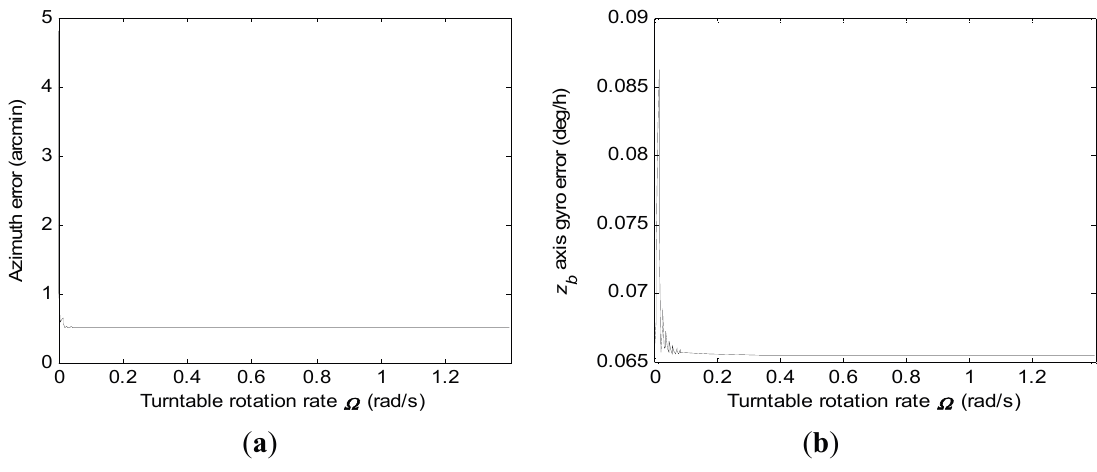
Figure 4. 1- σ values of final azimuth error and final z b axis gyro error at 600 s computed according to turntable rotation rates ranging from 0.0003 rad/s to 1.4 rad/s when using the conventional KF scheme. ( a ) Azimuth error; ( b ) z b axis gyro erro.